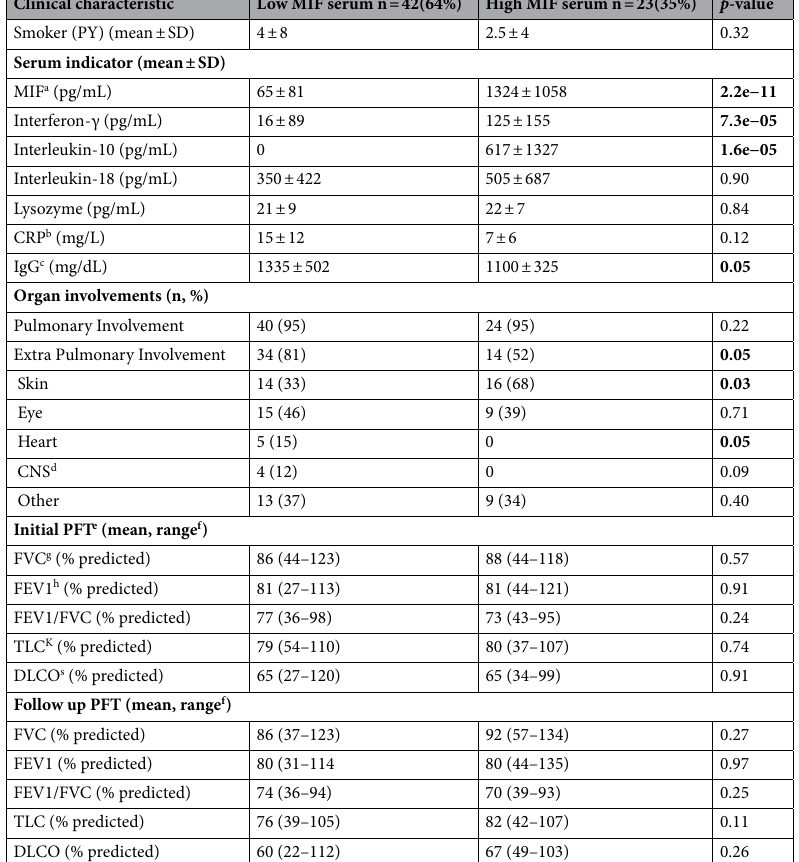
Table 2. Clinical characteristics based on serum MIF level. a Macrophage inhibitory factor, b C-Reactive protein, c Immunoglobulin G, d Central nerve system, e Pulmonary function test, f Range, g Forced vital capacity, h Forced expiratory volume, K Total lung capacity, s Diffusing capacity of lung for carbon monoxide. Significant values are in